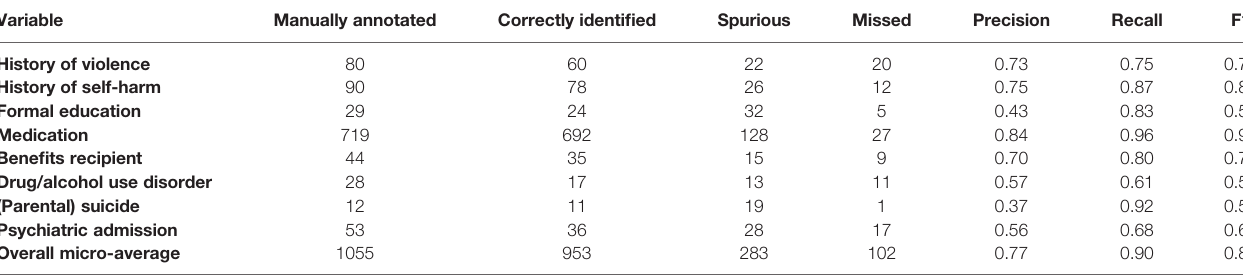
TABLE 3 | Named entity recognition model performance for concepts related to suicide